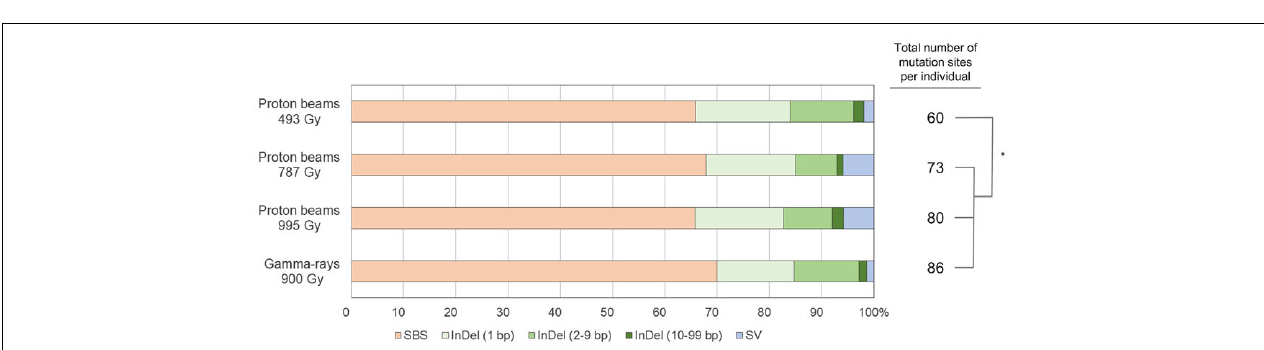
FIGURE 4 | Relative frequency and spectrum of DNA mutations induced by proton beam and gamma-ray irradiation. The asterisk indicates significant differences between groups ( p < 0.05 in student’s t -test).